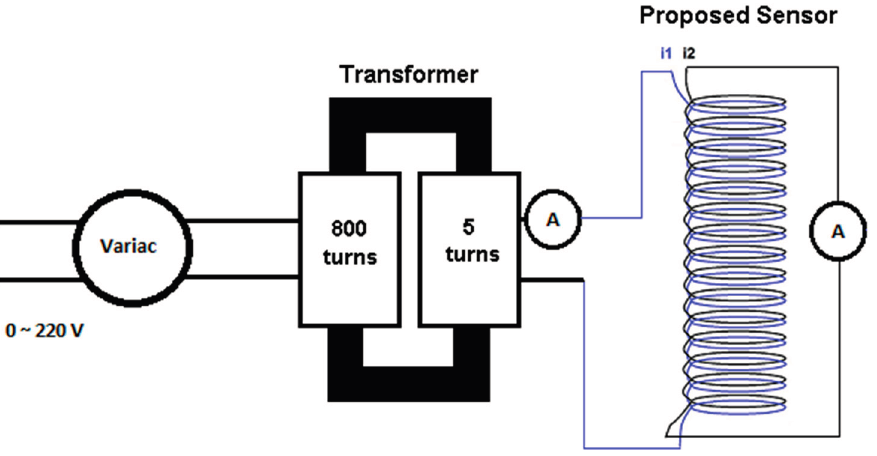
Figure 6. Electrical diagram of the test bench used in the current sensor characterization